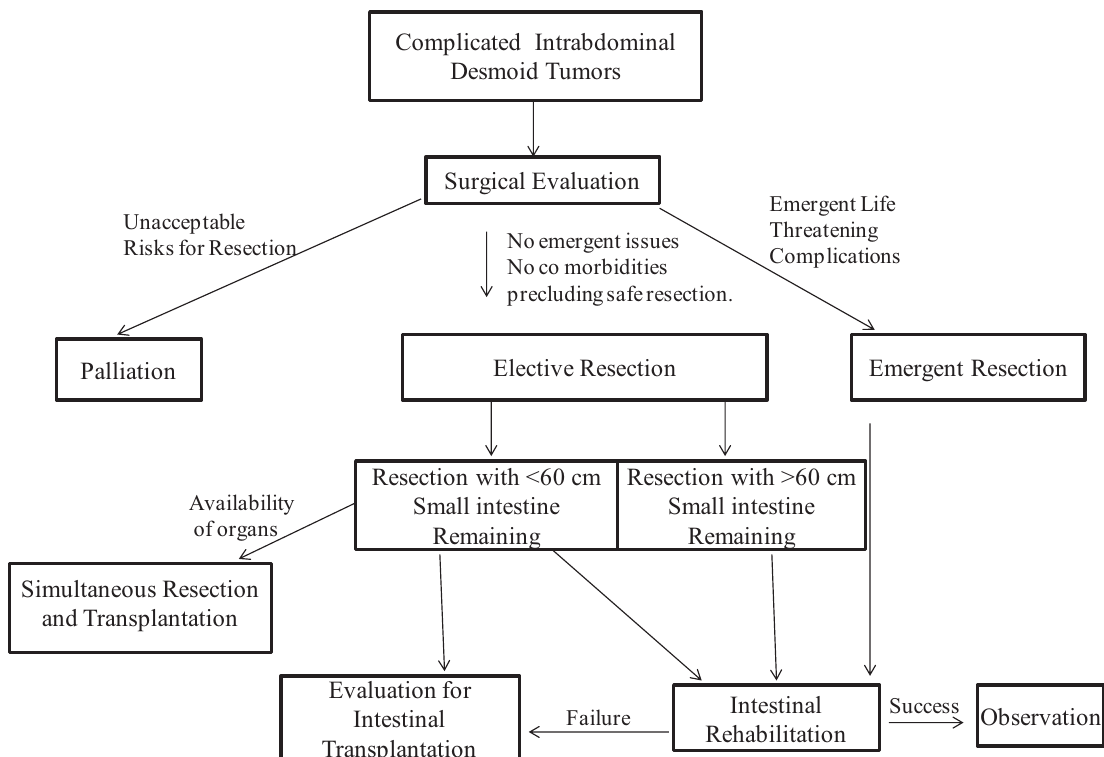
Figure 1. Treatment algorithm for the surgical management of complicated intra-abdominal desmoids